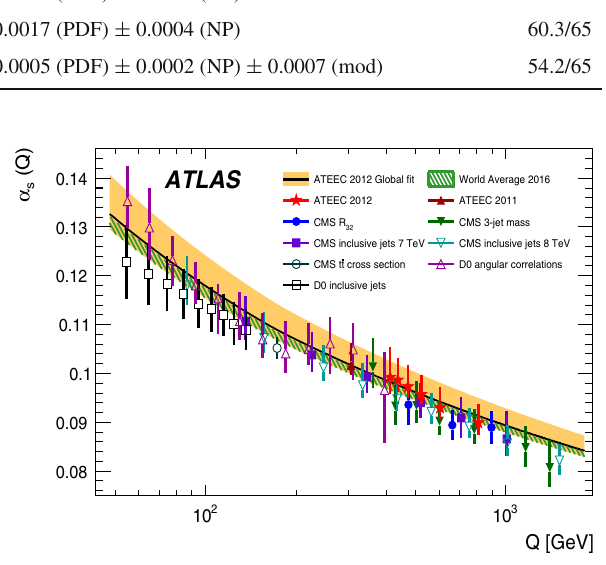
Fig. 11 Comparison of the values of α s ( Q ) obtained from fits to the ATEECfunctionsattheenergyscalesgivenby (cid:4) H T2 (cid:5) / 2(redstarpoints) with the uncertainty band from the global fit (orange full band) and the 2016 world average (green hatched band). Determinations from other experiments are also shown as data points. The error bars, as well as the orange full band, include all experimental and theoretical sources of uncertainty. The strong coupling constant is assumed to run according to the two-loop solution of the RGE